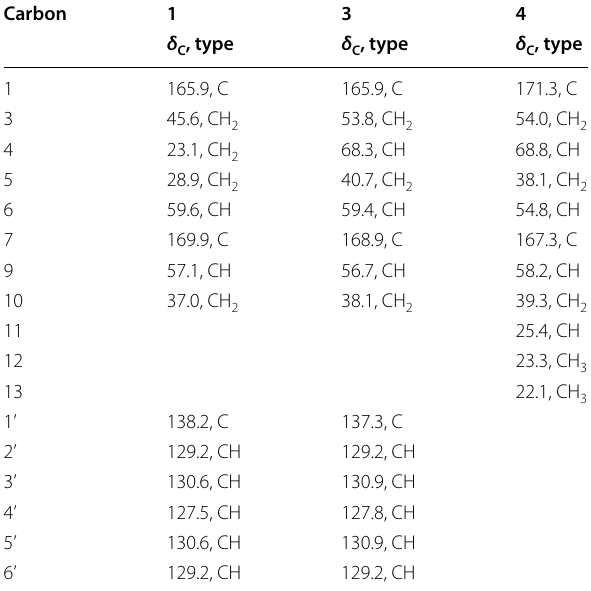
Table 5 13 C NMR data (acetone- d